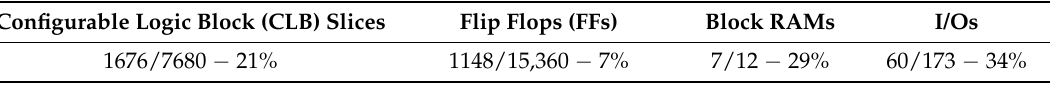
Table 3. Compression module resources (Spartan3E xc3s100 – 4ft256 Xilinx FPGA